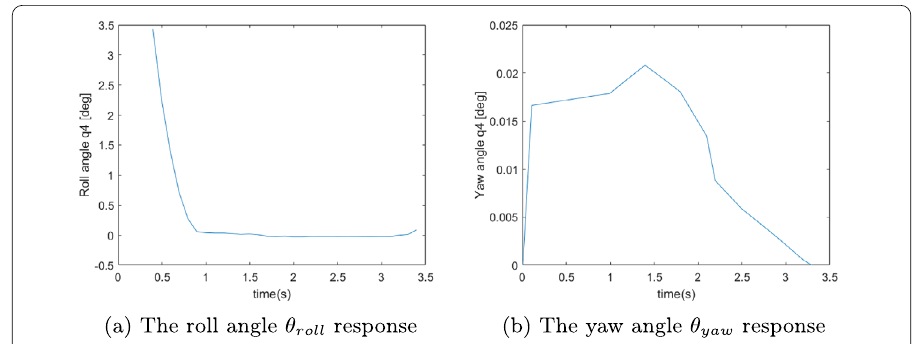
Figure 28 Backstepping control response results for the non-delay model with parameters c 1 = 5, c 2 = 5